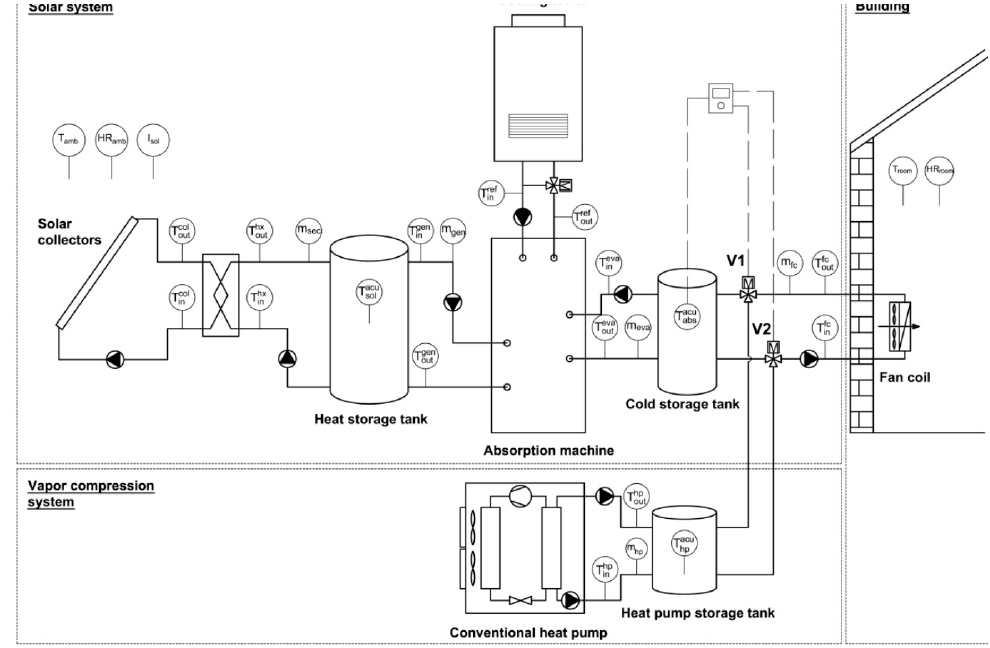
Figure 3. Scheme of the solar cooling system.